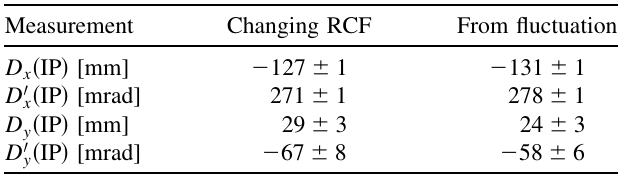
TABLE II. Comparison of the two dispersion fit methods using the IP as reference